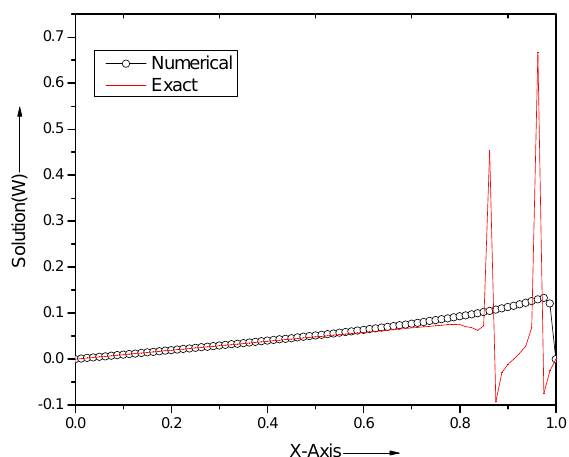
Figure 3. Comparison of analytical and numerical results for problem 5.1 with ν d = 0.2, ∆ x = 0.0125 and τ = 0.001 and at different times T .